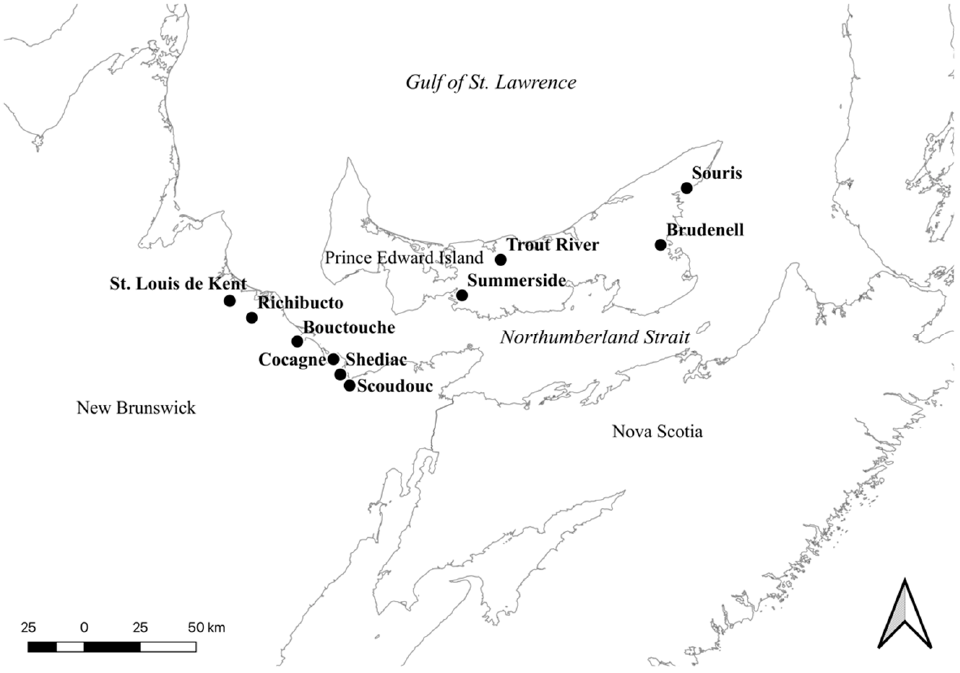
Figure 1. Map of the ten CAMP estuaries sampled in 2016. Map created using the Free and Open Source QGIS. Table 1. Site information for the Canadian Aquatic Monitoring Program (CAMP) estuaries sampled in 2016, including estuary area and watershed characteristics.